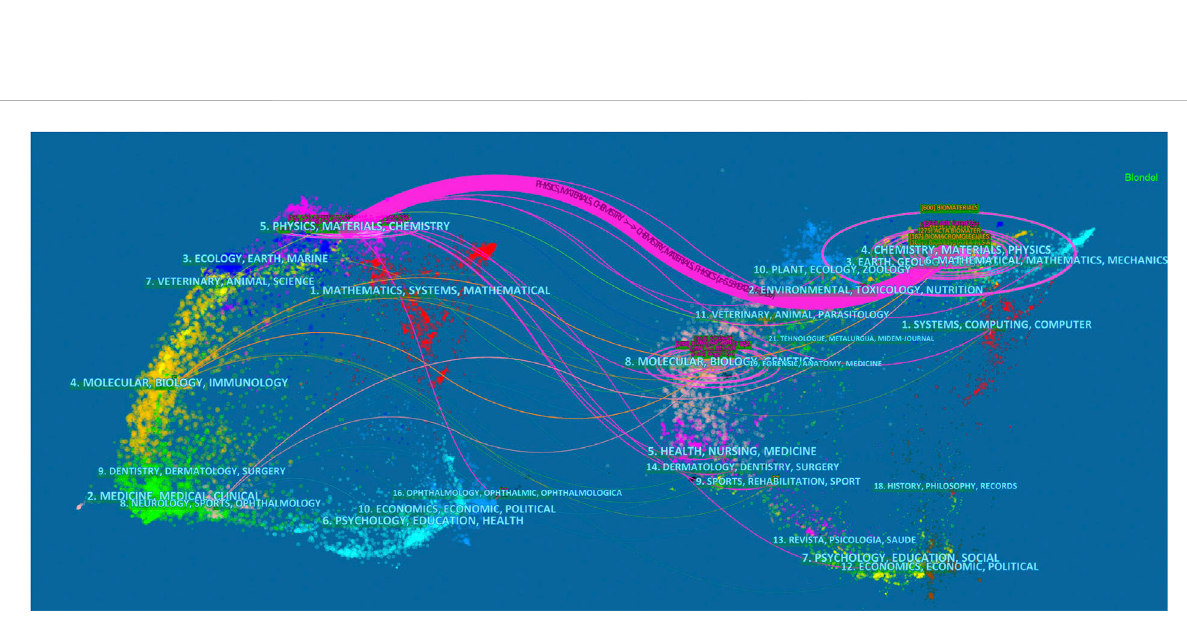
(Figure 7B) shows that “ copolymer ” , “ microfabrication ” , “ stem cells ” , “ in vitro ” cells culture, and “ (drug) delivery ” had all been the hotspots of TPP applications in biomedical. In recent years, the research